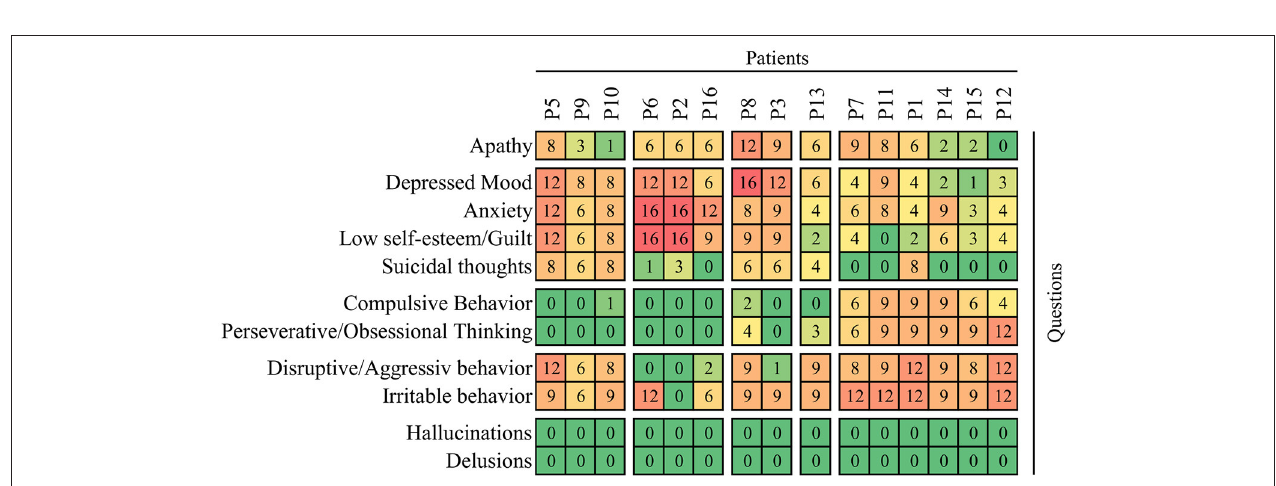
FIGURE 2 | Individual profiles of behavioral impairment at baseline of observation before administration of cariprazine. The frequency x severity scores are shown on the heatmap with the maximum 16 points calculated as product of 4 (which means very frequently, most all the time on a 0–4 scale) and 4 (severe, causing a restriction of activities). The rows (questions/items) and columns (patients) are clustered on the basis of average correlation and separated in blocks according to first-order branches of